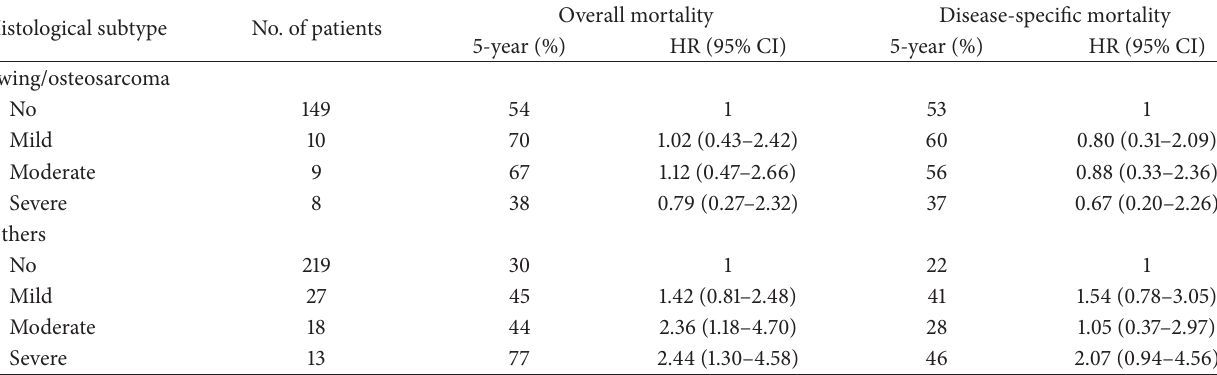
Table 5: Multivariate analyses for the effect of comorbidity on overall and disease-specific mortality according to histological subtype. Histological subtype